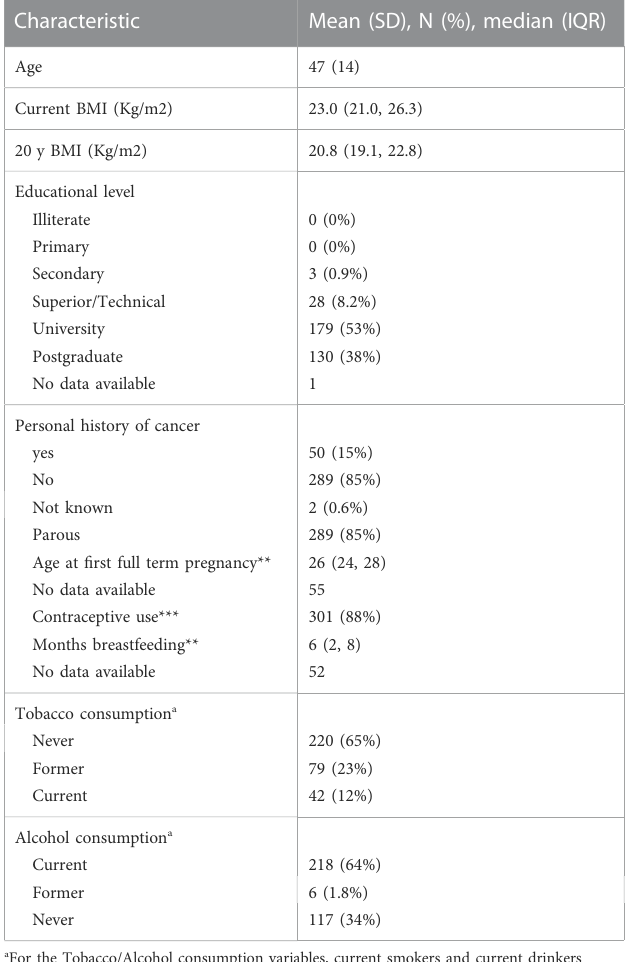
TABLE 1 Demographic characteristics of women of Ashkenazi Jewish ancestry who reside in Mexico City ( N = 341).